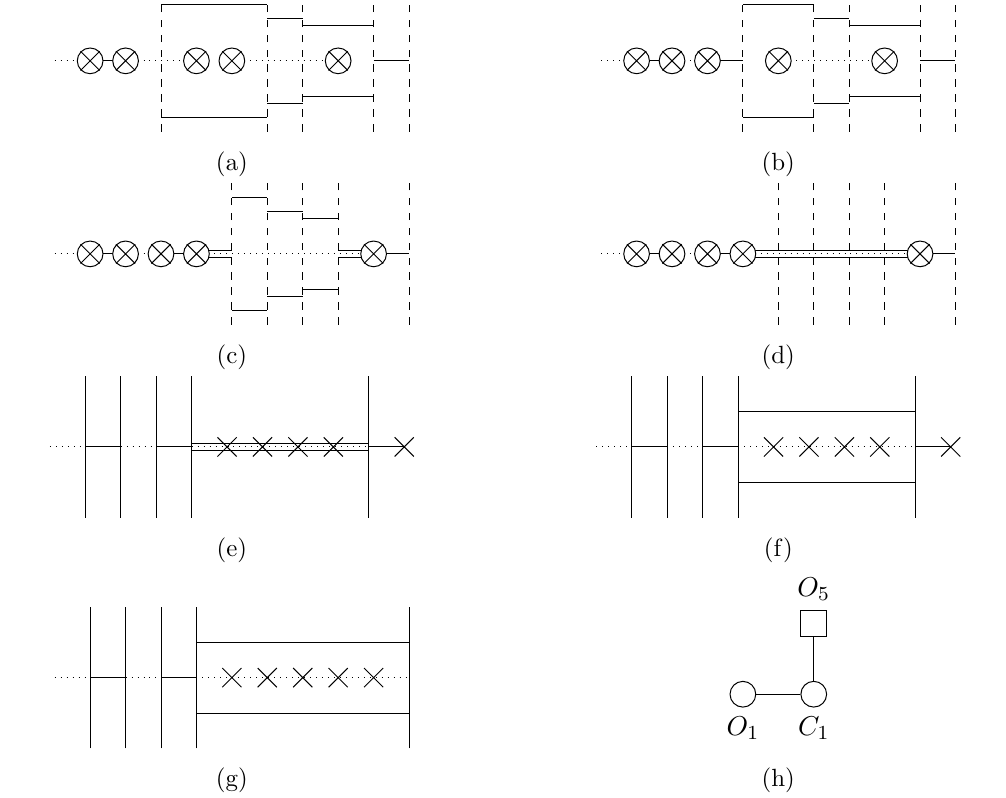
Figure 34. Phase transition to the Coulomb branch brane con(cid:12)guration. In order to read the quiver for the model resulting after the A 3 KP transition in (cid:12)gure 33(f). (a) Higgs branch of the model. (b-e) Phase transitions. (f) Coulomb branch of the model before the collapse transition. (g) Coulomb branch of the model after the collapse transition. (h) Quiver, it can be identi(cid:12)ed with the model whose Higgs branch is the closure of the next to minimal nilpotent orbit of so (5), correspondig to partition (cid:21) = (3 ; 1 2 ): M H = (cid:22) O (3 ; 1 2 )